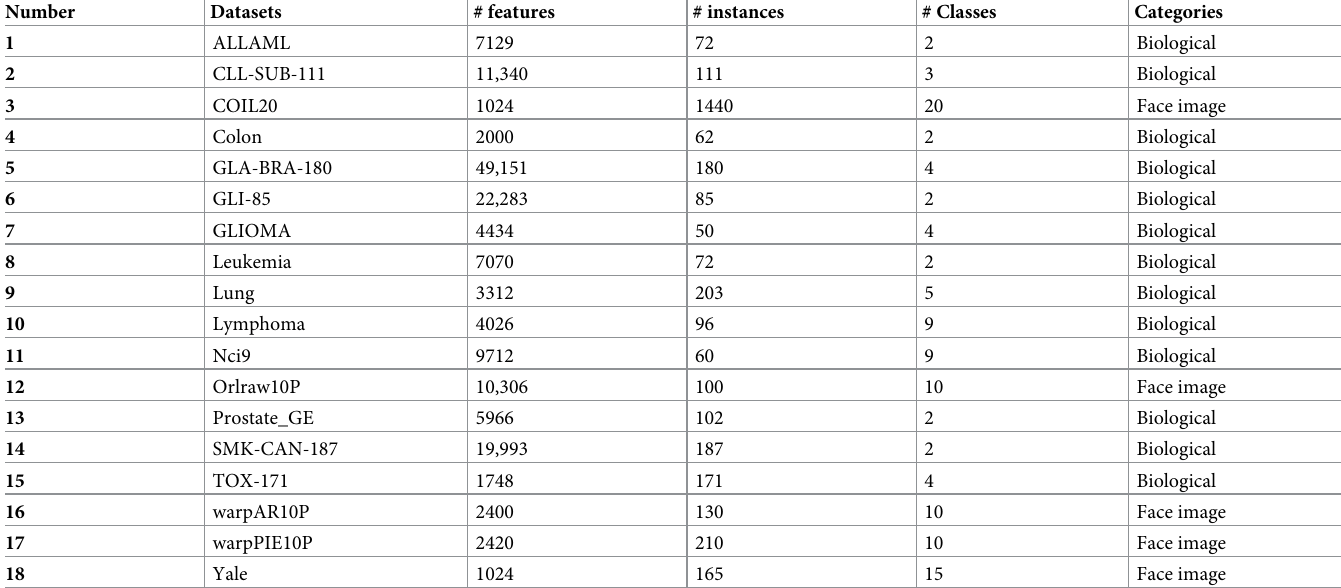
Table 1. Dataset and their